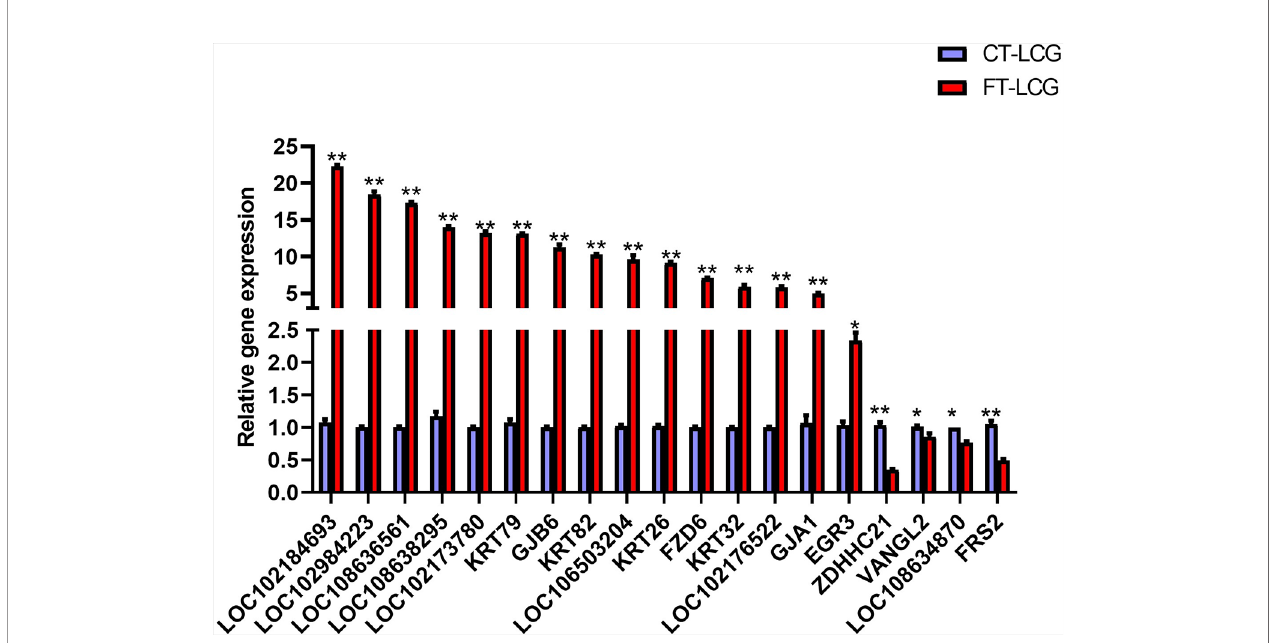
FIGURE 6 | qPCR results of the 19 differentially m6A modi fi ed genes in FT-LCG and CT-LCG. The blue-purple column represents CT-LCG, the red column represents FT-LCG, ** represents P < 0.01, * represents P <